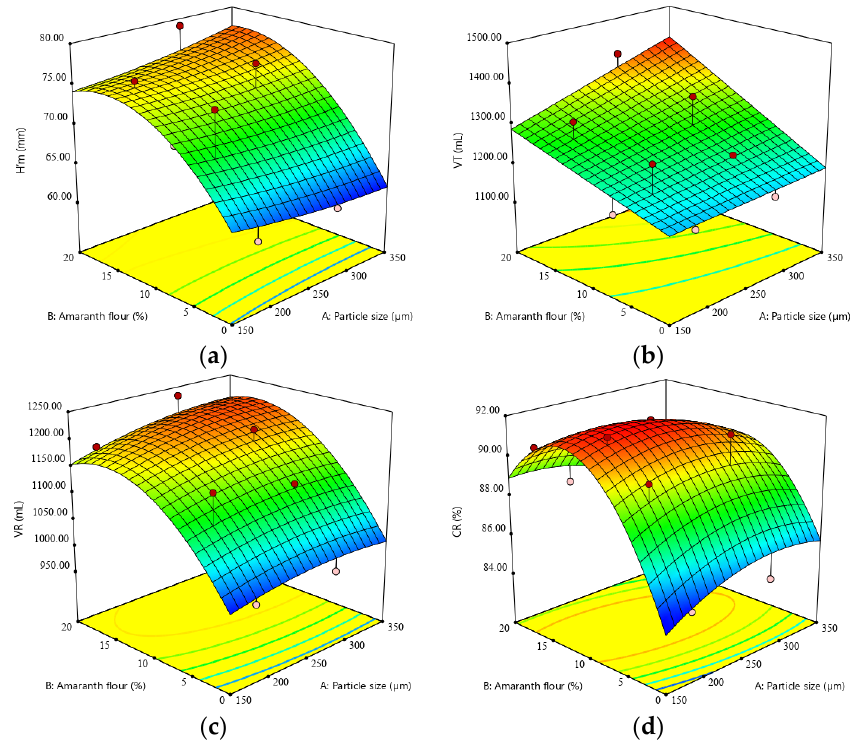
Figure 4. Three-dimensional response surface plots showing the interaction between amaranth flour particle size and addition level on: ( a ) maximum height of the gas release curve (H’m); ( b ) total CO 2 volume production (VT); ( c ) volume of the gas retained in the dough at the end of the test (VR); and the ( d ) retention coefficient